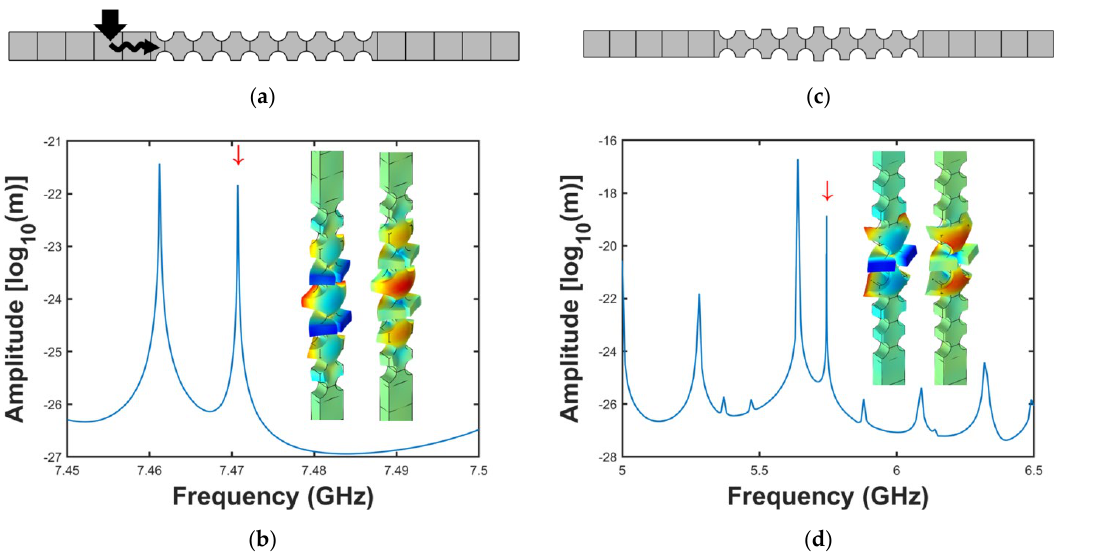
Figure 2. Sketches of the type-I fishbone and the standard fishbone (the control group): ( a ) A sketch of the standard fishbone. ( b ) The frequency spectrum of the standard fishbone. The SS mode is marked by a red arrow, and the insets are the displacement field (left) and the strain field (right). ( c ) A sketch of the type-I APW fishbone. ( d ) The frequency spectrum of the type-I fishbone. The SS mode is marked by a red arrow, and the insets are the displacement field (left) and the strain field (right).